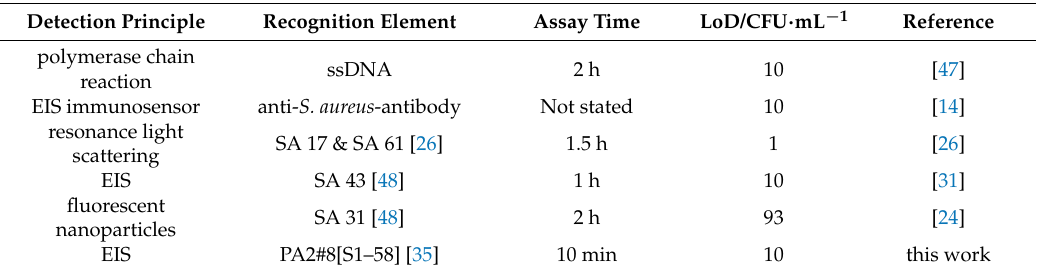
Table 4. Comparison of several detection methods for Staphylococcus aureus (SA = S. aureus aptamer, LoD = limit of